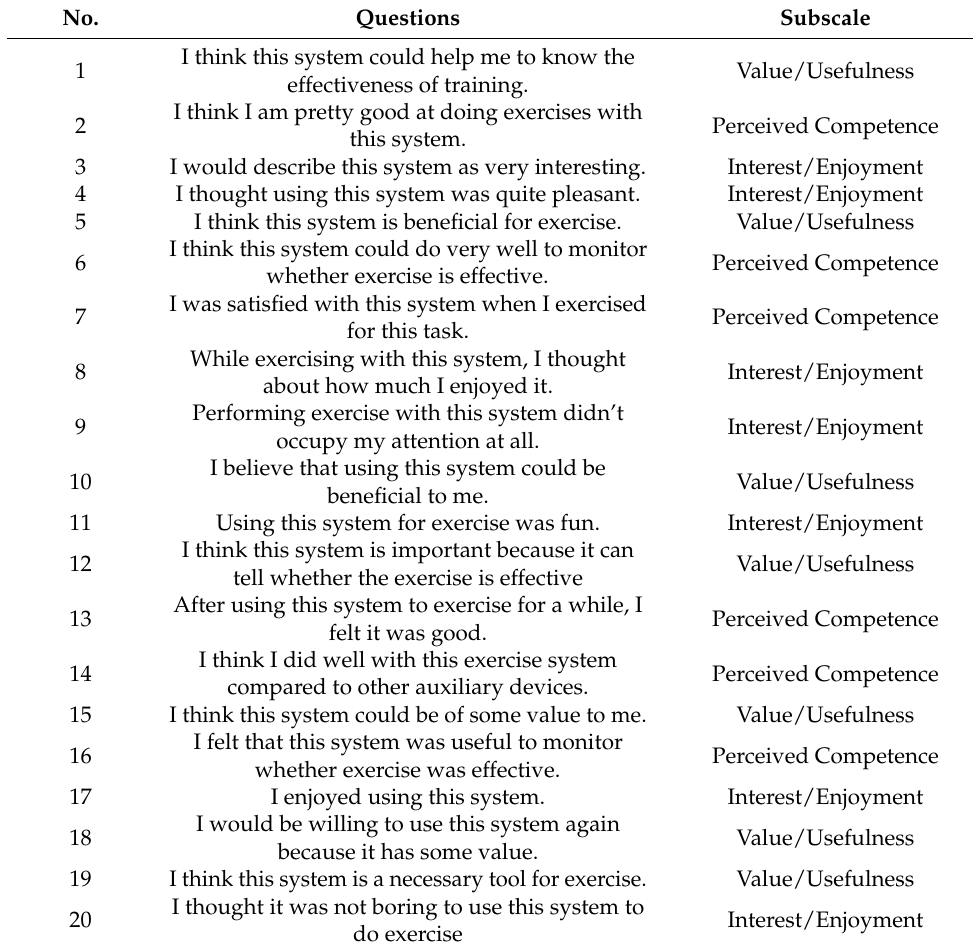
Table 2. User experience